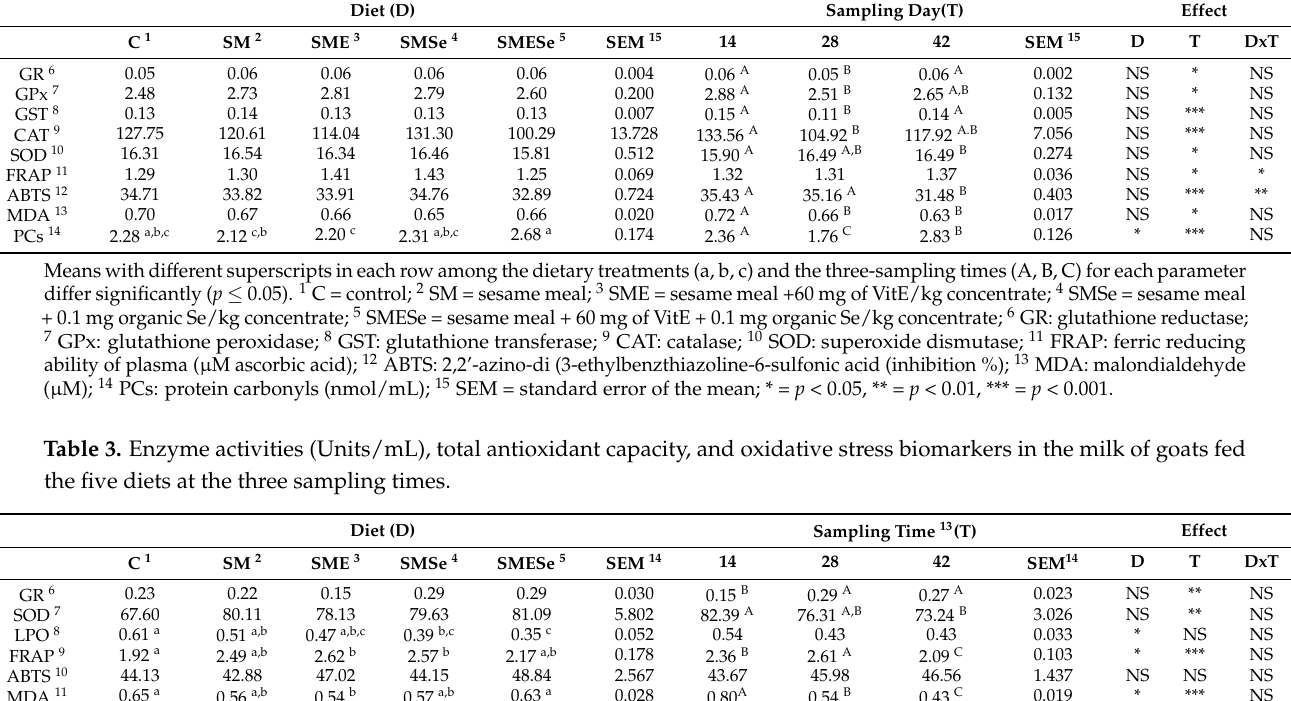
Table 2. Enzyme activities (Units/mL), total antioxidant capacity, and oxidative stress biomarkers in the blood plasma of goats fed the five diets at the three sampling times.eldar tactics.